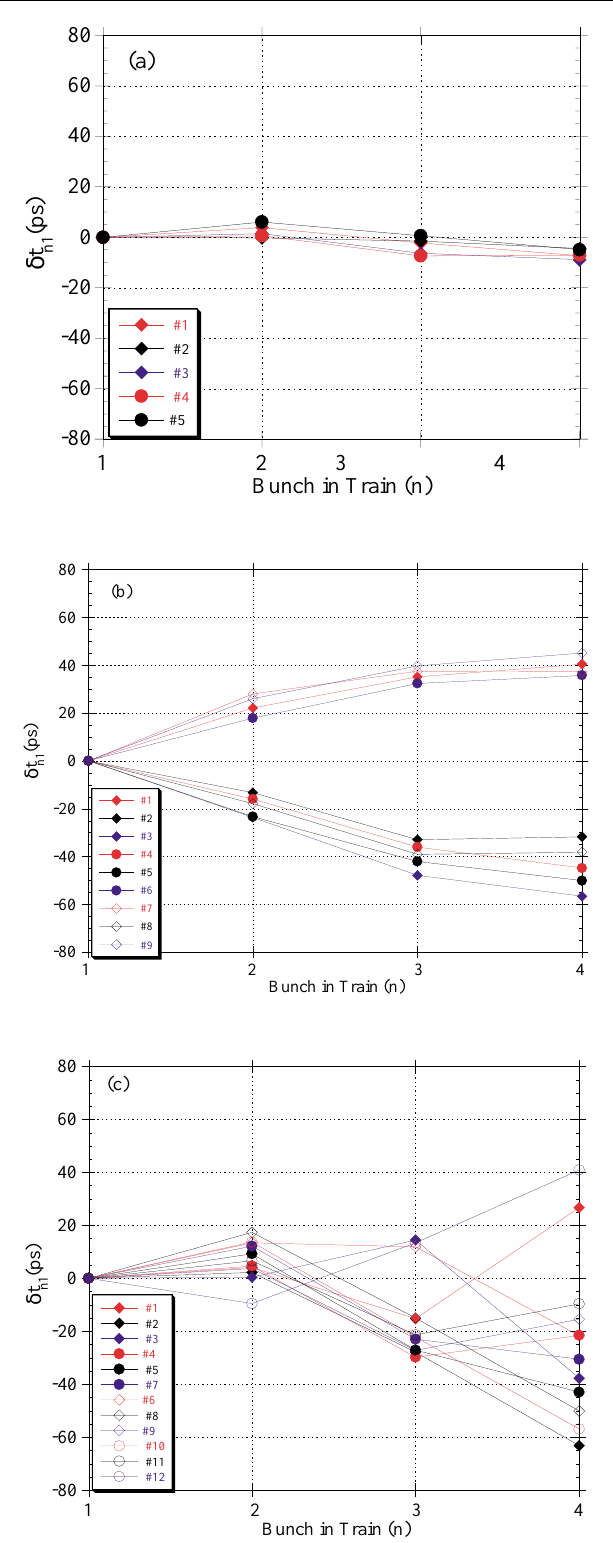
FIG. 14. (Color) The time of arrival oscillation ( d t n 1 ) when (a) the train is stable and the total beam current is 276 mA, (b) the train is unstable and the total beam current is 276 mA, and (c) the train is unstable and the total beam current is 326 mA.